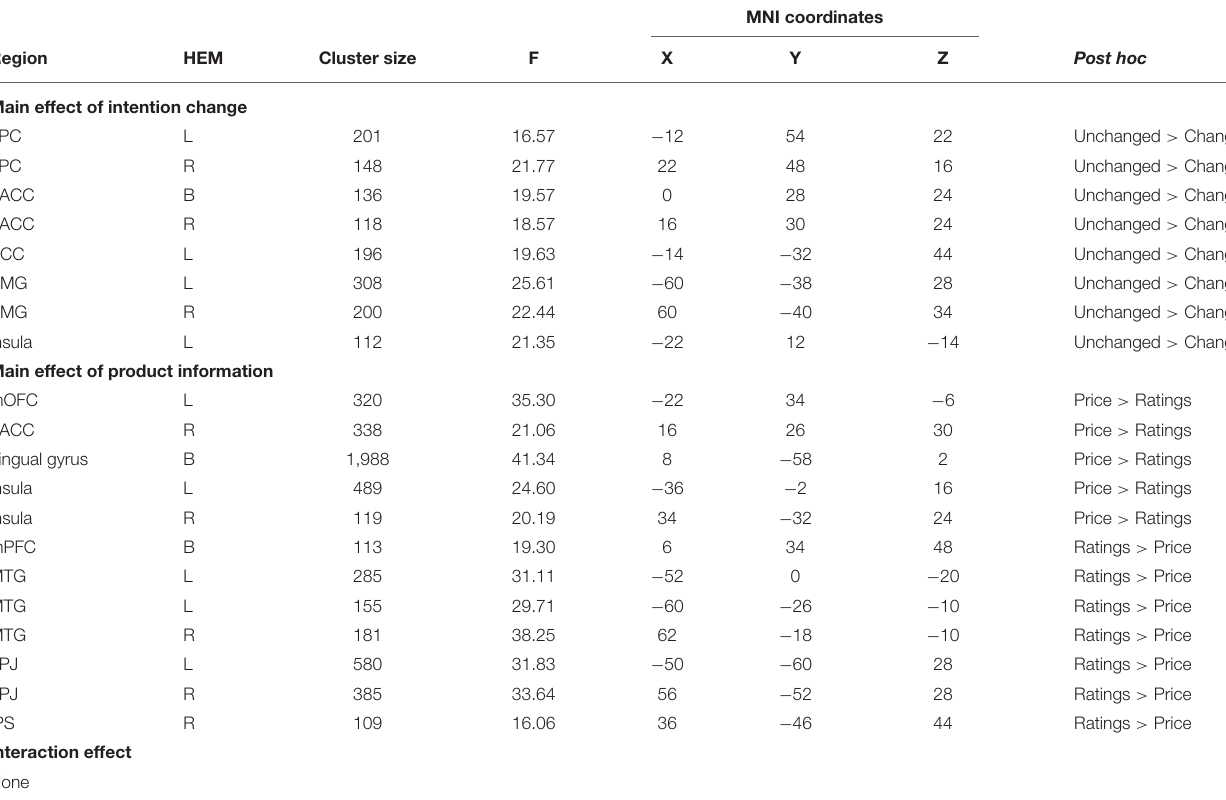
MNI coordinates